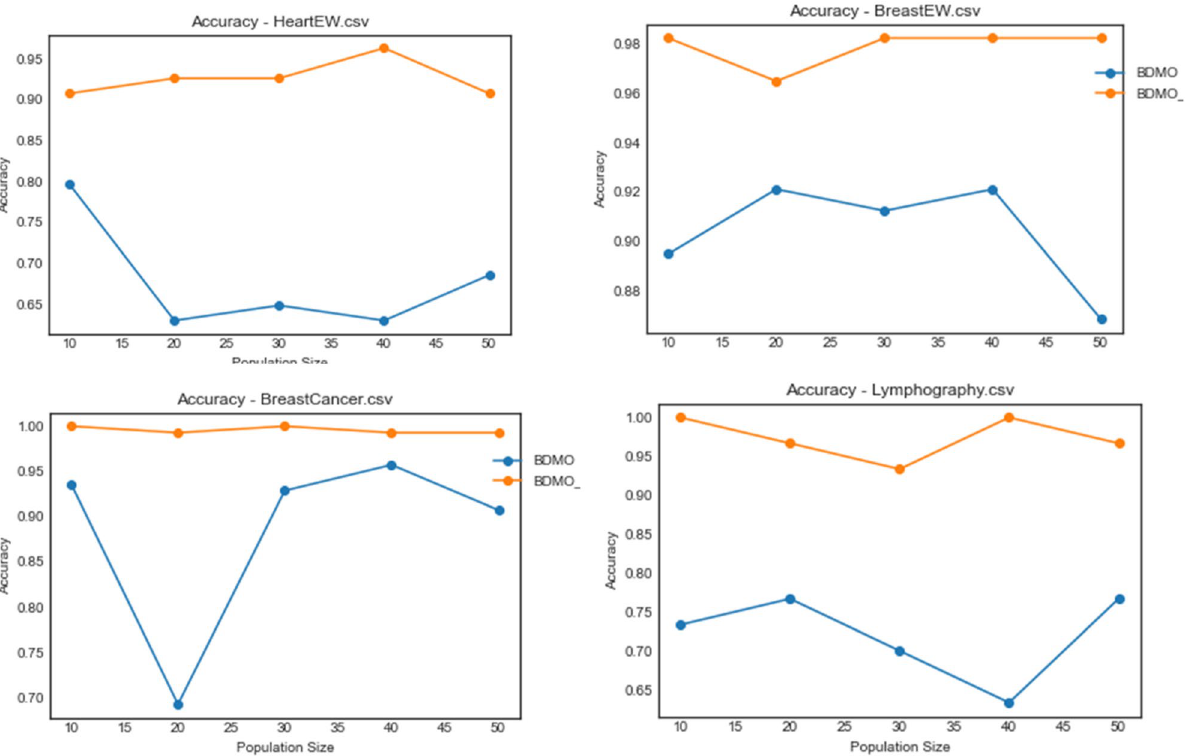
Figure 7. Accuracy plot of the BDMSAO and BDMO on HeartEW, BreastEW, BreastCancer, and Lymphography datasets. Statistical